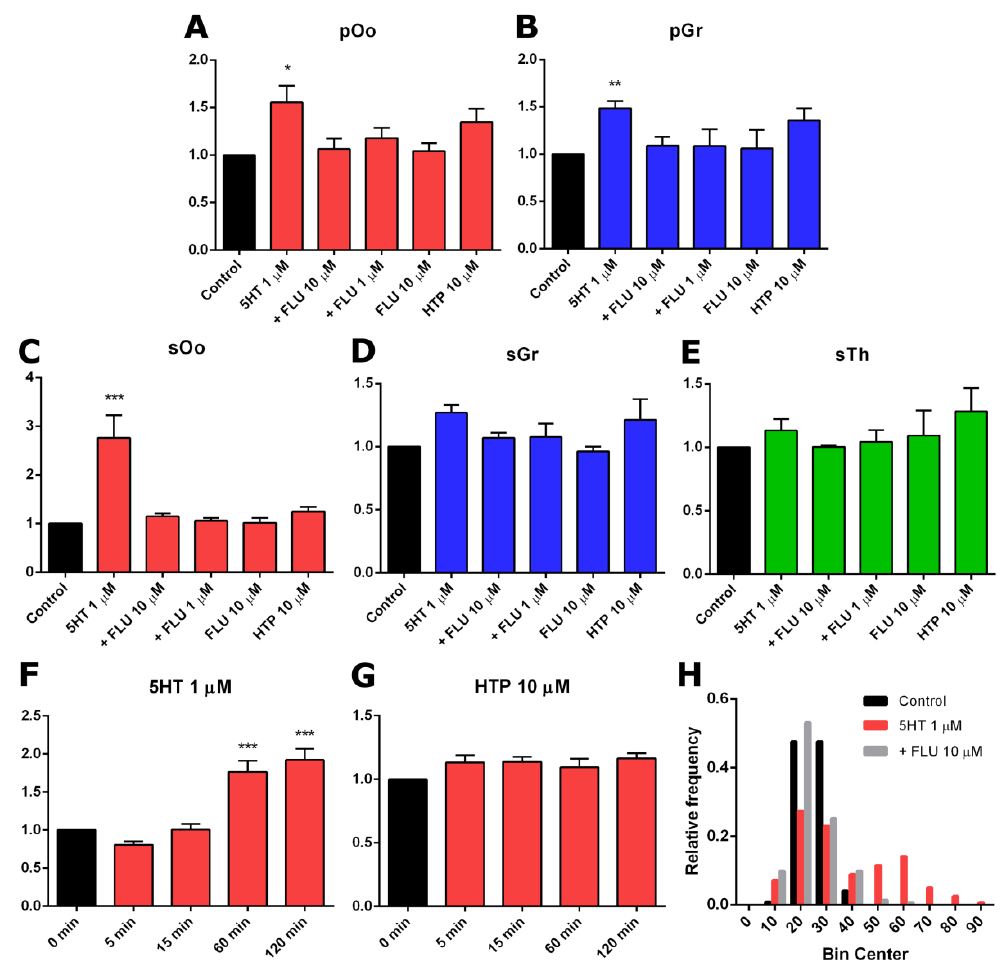
Figure 6. Quantitative analysis of serotonin accumulation in the study of the activity of the systems of its synthesis and uptake in mouse ovaries. ( A – E ) Quantitative analysis of anti-serotonin immunoreactivity in individual cellular compartments of mouse ovaries after incubation with serotonin (5HT), with 5HT and previous addition of fluoxetine ( + FLU), with fluoxetine only (FLU) and with 5-hydroxytryptophan (HTP): sOo–oocyte, sGr–granulosa cells and sTh–theca cells of the secondary (preantral) follicle; pOo–oocyte and pGr–granulosa cells of primordial follicle (M ± SEM). The level of immunofluorescence in the control sample is taken as 1. * Denotes statistical significance at p < 0.05, ** at p < 0.01 and *** at p < 0.005, between control and treated groups, using the Friedman test. ( F , G ) The temporal dynamics of serotonin accumulation in oocytes of growing follicles (sOo) during incubation with 5HT (1 µ M) and HTP (10 µ M) (M ± SEM). *** Denotes statistical significance at p < 0.005, between control and treated groups, using the Friedman test. ( H ) Frequency distribution histogram of serotonin accumulation in oocytes of growing follicles (sOo). A bimodal distribution is observed in the 5HT group.